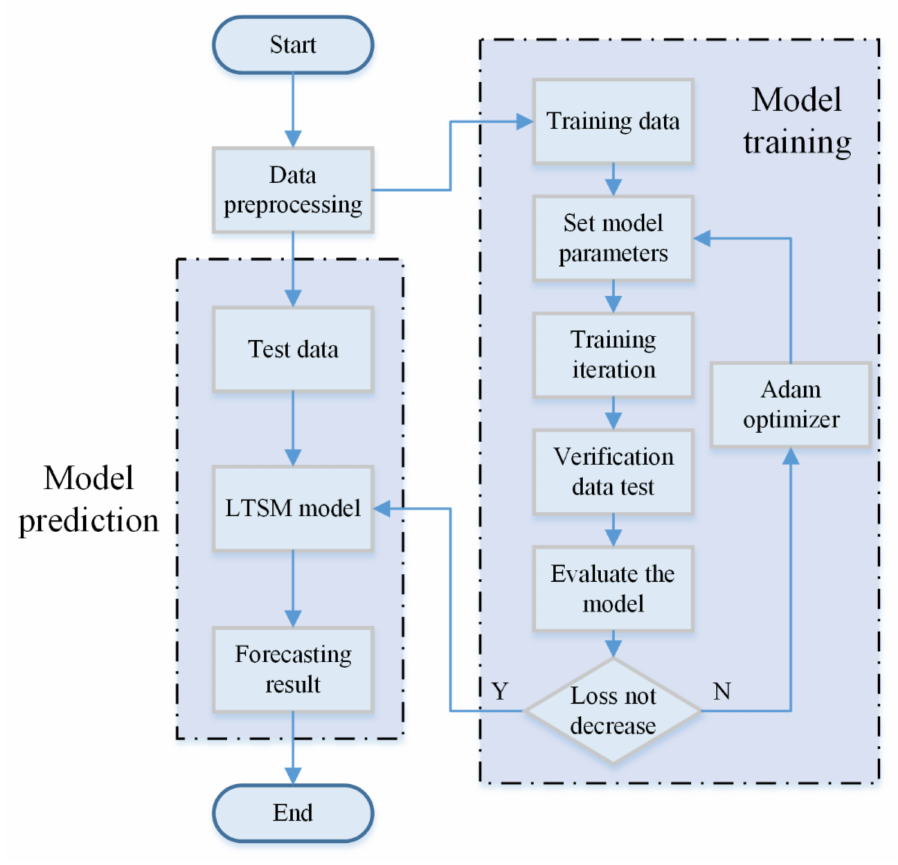
Figure 5. The full flowchart of the LSTM